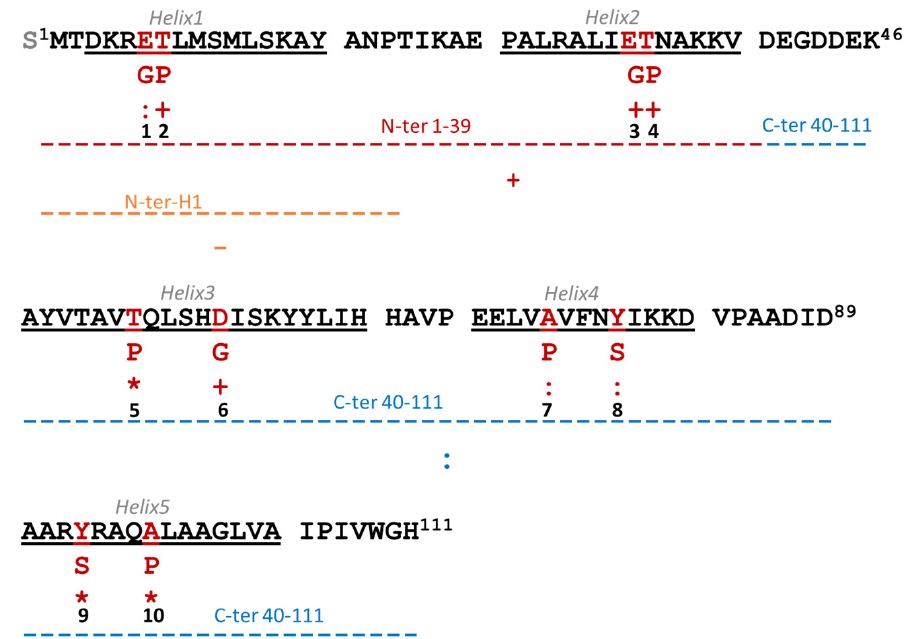
Figure 4. Amino acid sequence and predicted three-dimensional structure of lacticaseicin 30. The predicted helical regions (helix 1 to helix 5) are underlined. Truncated forms of lacticaseicin 30 are shown by colored dotted lines (red: N-ter-Lacticaseicin 30, orange: N-ter-H1-Lacticaseicin 30 and blue: C-ter-Lacticaseicin 30). Mutated amino acids of variants are in red. Lacticaseicin 30 variants generated by directed mutagenesis are designated by a number between 1 and 10 (1: E6G, 2: T7P, 3: E32G, 4: T33P, 5: T52P, 6: D57G, 7: A74P, 8: Y78S, 9: Y93S and 10: A97P). Activities in the same range as native lacticaseicin 30 and total absence of activity are shown by + and − , respectively; * and “:” indicate successively a gradual decrease of activity.